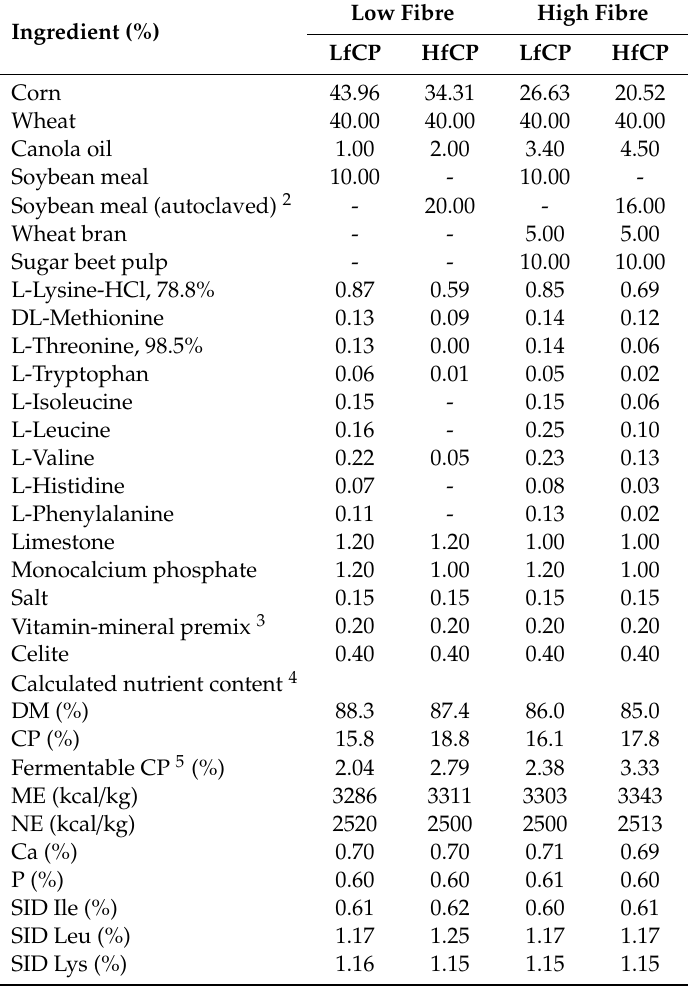
Table 1. Composition of basal experimental diets (as-fed basis) 1